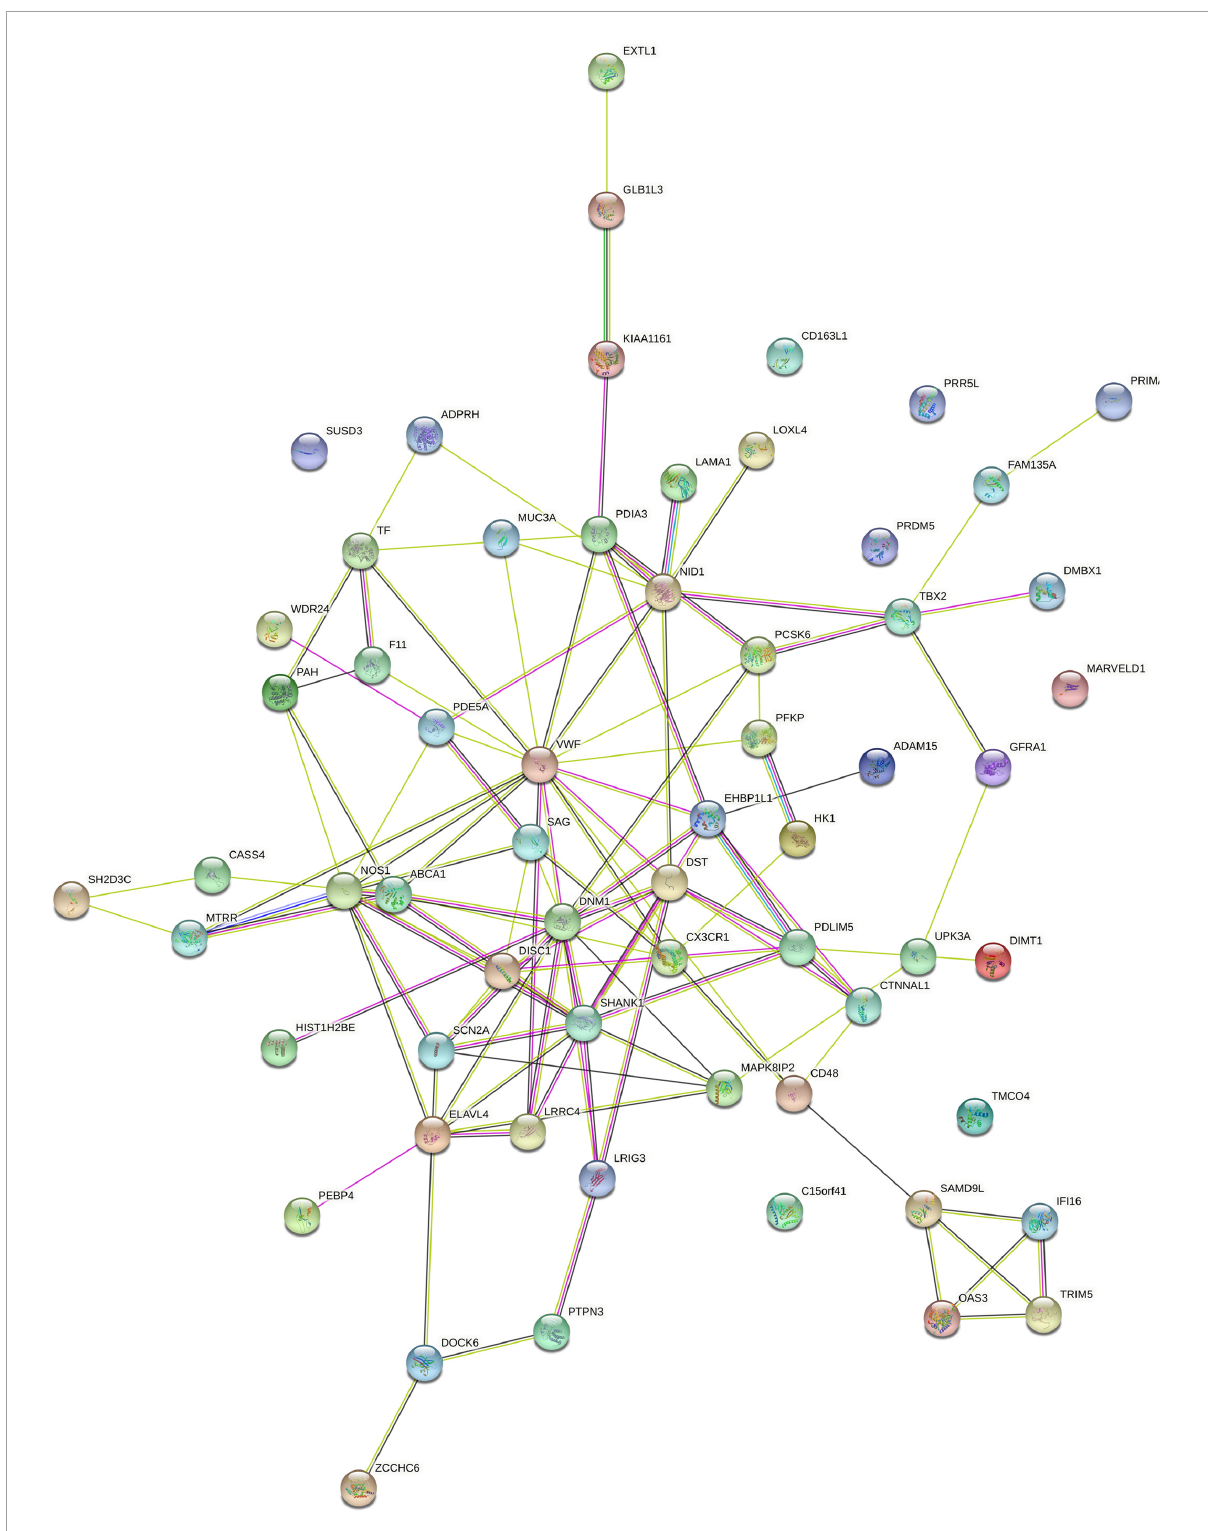
FIGURE5 PPI networks constructed by 62 identified genes related to brain WMV changes. PPI, protein-protein interaction; WMV, white matter